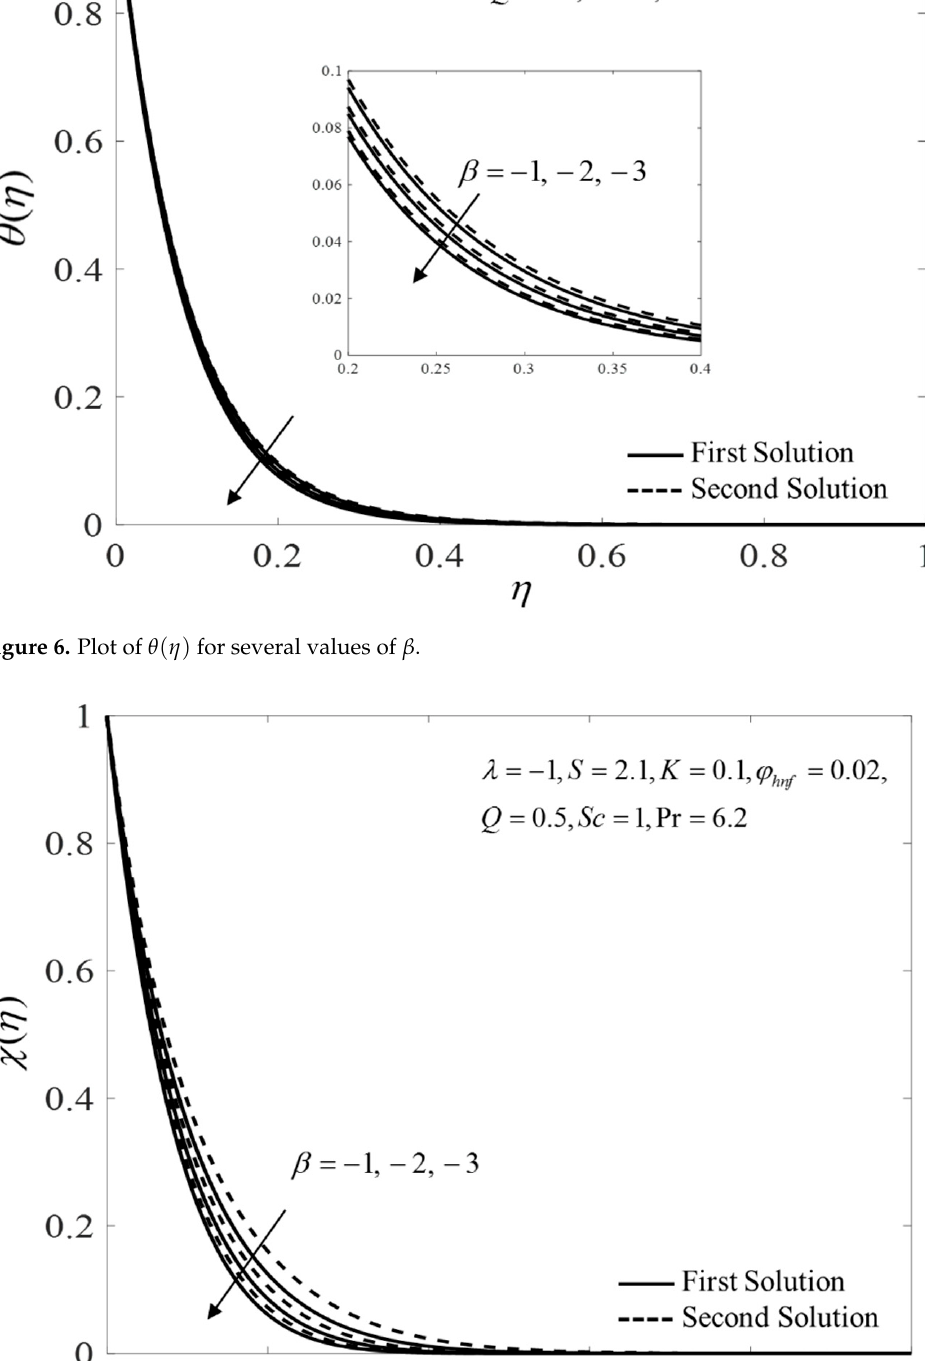
( η ) for several values of β Figure 7. Plot of ( )  for several values of  . Figure 7. Plot of χ